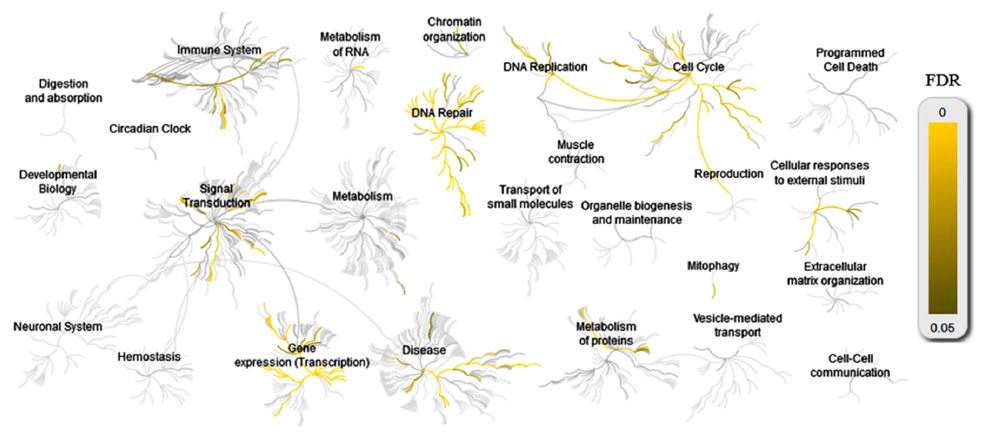
Figure 11. Over-representation analysis of Reactome pathways. The plots are separately made for differentially expressed genes between SN and MC-HL cell lines for DNA repair ontology.